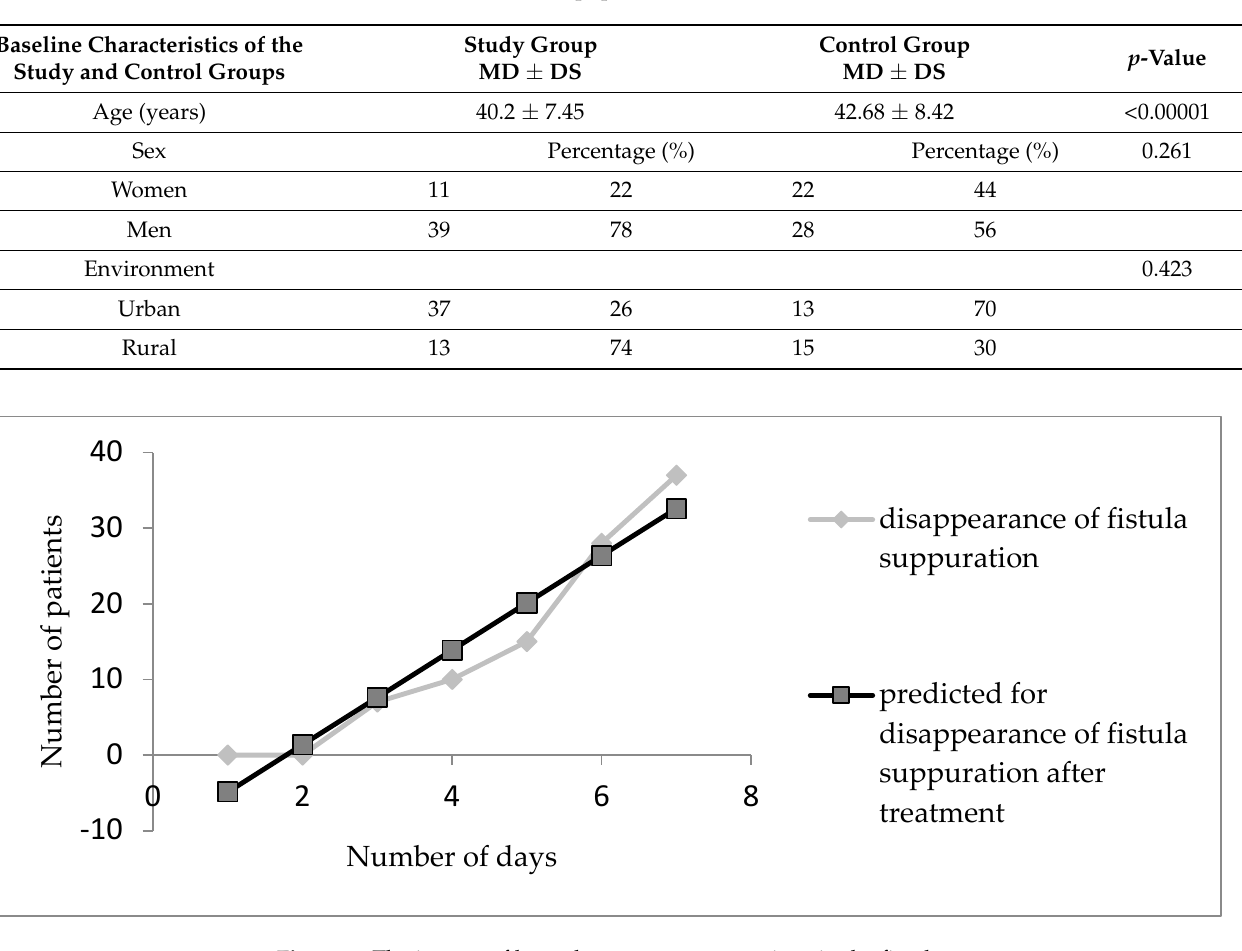
Figure 2. The impact of laser therapy on suppurations in the fistula.